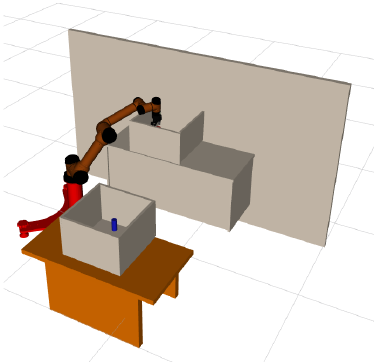
Figure 9. The scene for pick-and-place tasks in MoveIt! ( a ), AUBO − i5 physical manipulator ( b ).